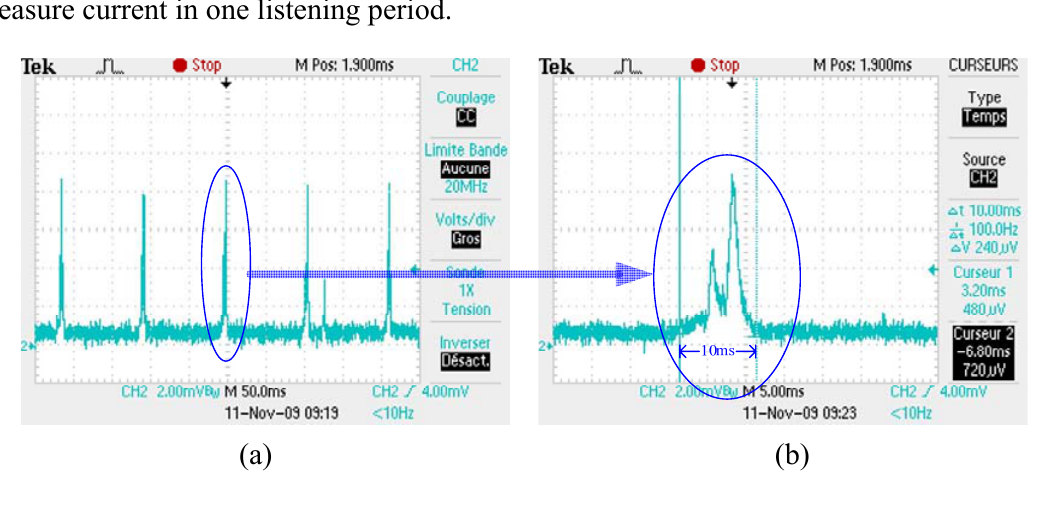
Figure 18. The detailed values of the measured listening